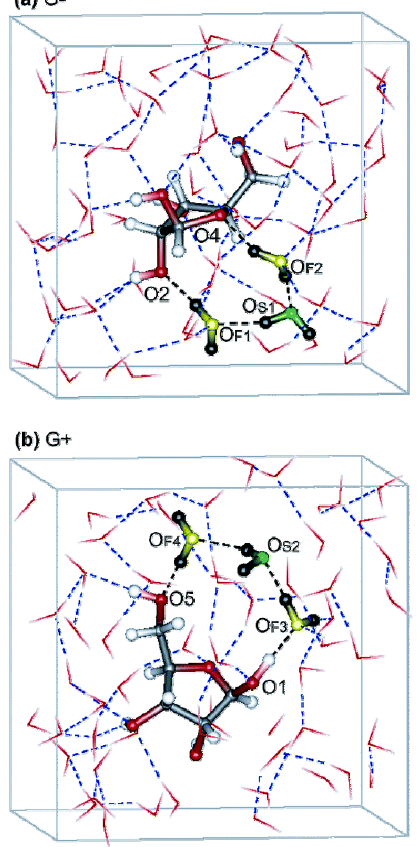
Figure 2. Representative configurations showing circular hydrogen bond networks near the ring oxygen in hydrated G − ( a ) and G+ ( b ) rotamers of β -ribofuranose sampled from ab initio MD trajectories by Suzuki and Soto [69]. Hydrogen bonds in the circular hydrogen bond networks are colored separately in black, while others are in blue. The three water molecules that form the circular hydrogen bond networks are represented by ball-and- sticks, where oxygens of the first and second hydration shell water molecules are colored separately in yellow and green with hydrogens in black, as well as labeled by the subscripts F and S, respectively. β -ribofuranose and the other water molecules are represented by ball-and-sticks and sticks, respectively (carbon atoms, grey; oxygens, red; hydrogens,